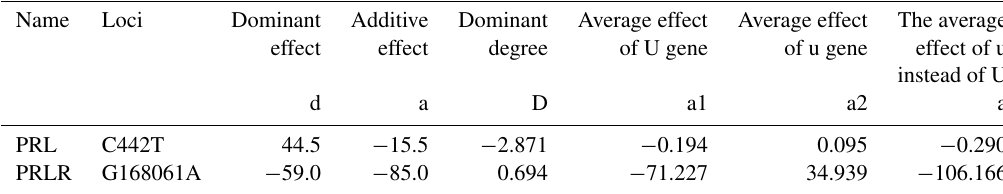
Table A3. Analysis of gene replacement effect of PRL gene and PRL gene.